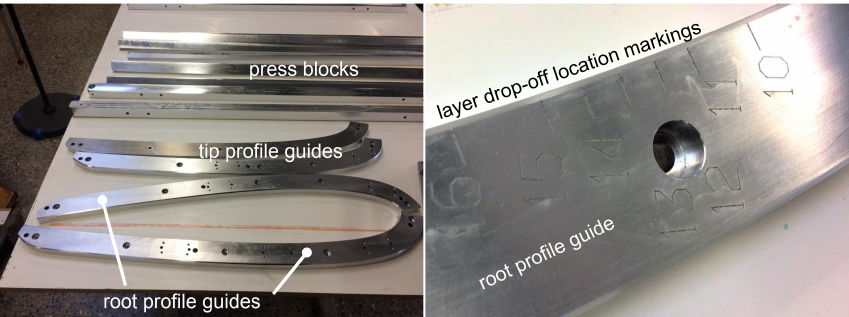
Figure 9. Machined press blocks and profile guides showing thickness-tailoring layer drop-off